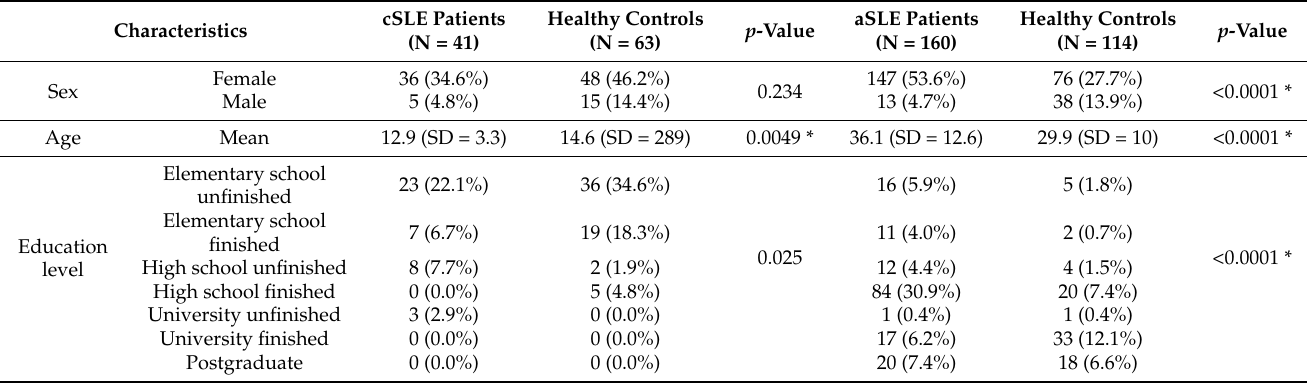
Table 2. Sociodemographic characteristics of the total sample divided by childhood-onset and adult-onset SLE.